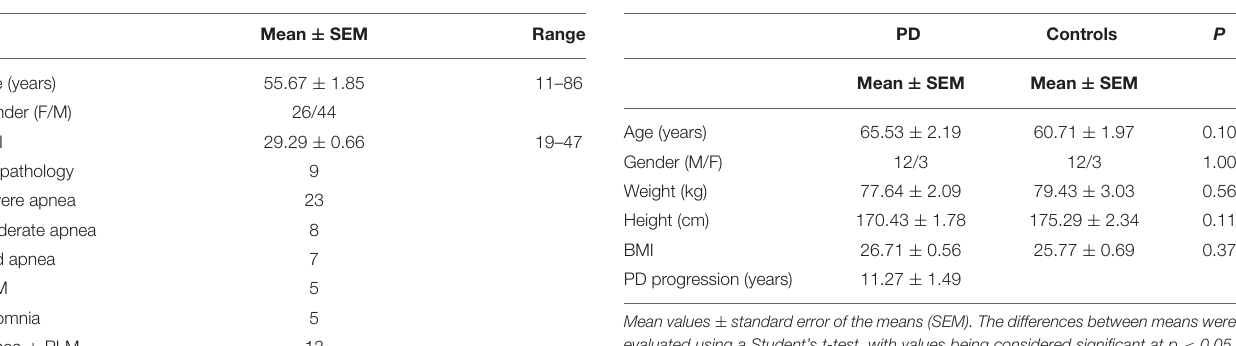
TABLE 1 | Characteristics of the subjects participating in the polysomnographic validation study.